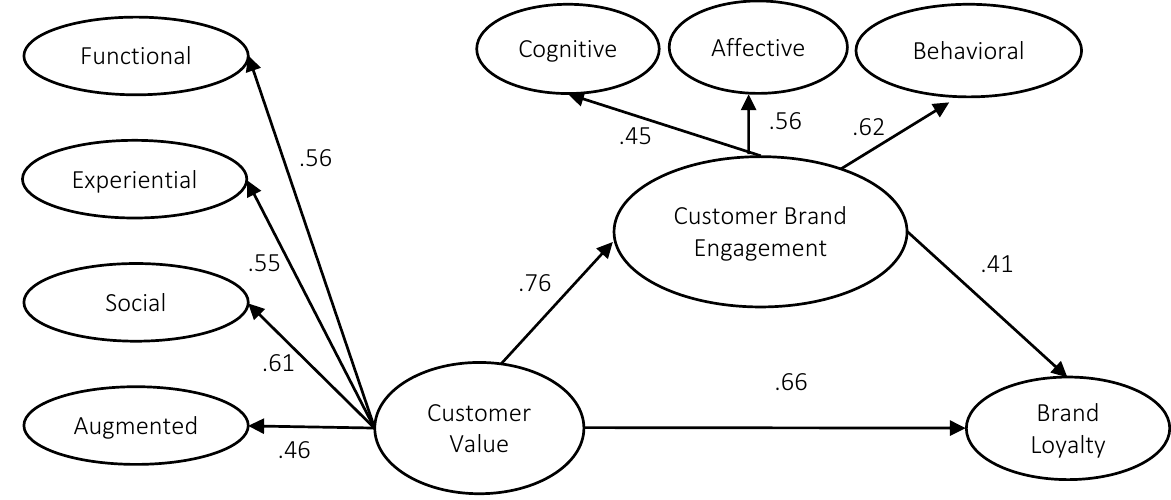
Figure 2. Structural model predicting brand